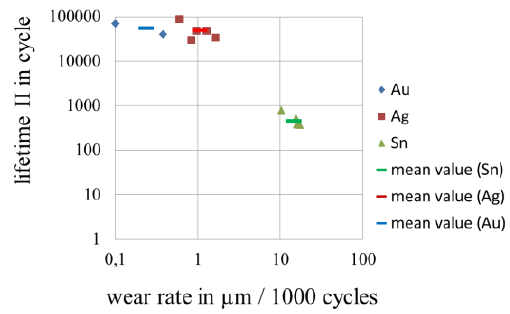
Figure 32. Correlation between the rate of wear and lifetime II of electrical contacts with different coating